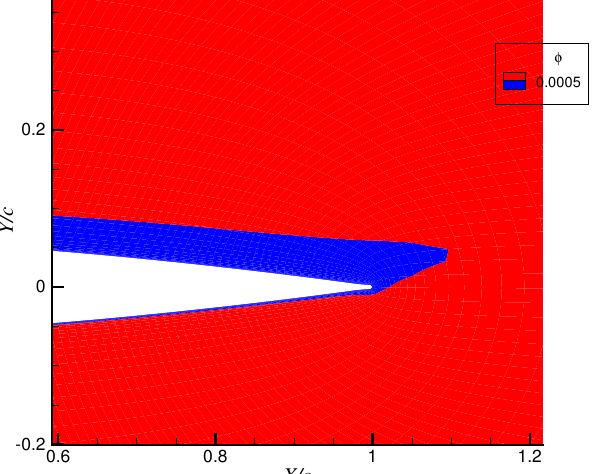
Figure 13. Droplet shadow zone at the airfoil trailing edge. The blue area is the droplet shadow zone where the liquid water content is considered to be